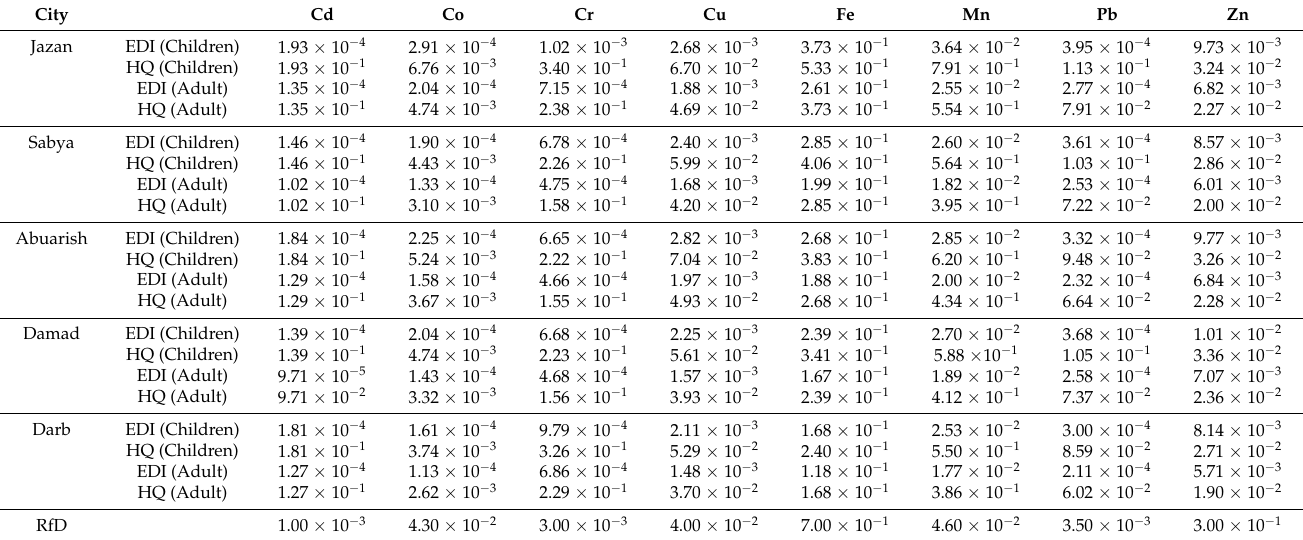
Table 4. Estimated daily intake (EDI, mg/kg /day), reference dose (RfD, mg/kg /day) and hazard quotient (HQ) of the tested heavy metals in selected leafy vegetables in the Jazan region.